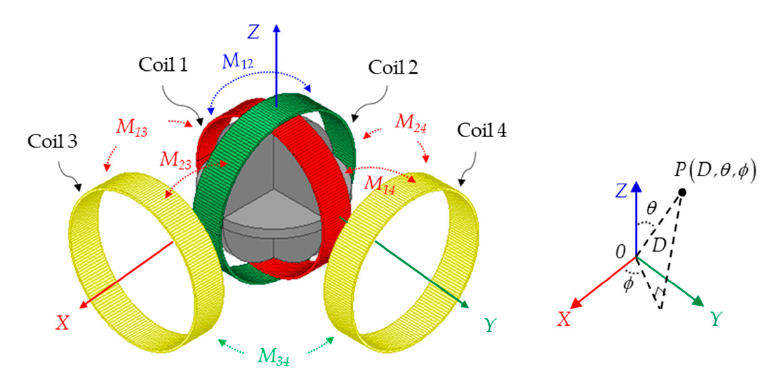
Figure 1. System configuration of multi-output omnidirectional wireless power transfer system.